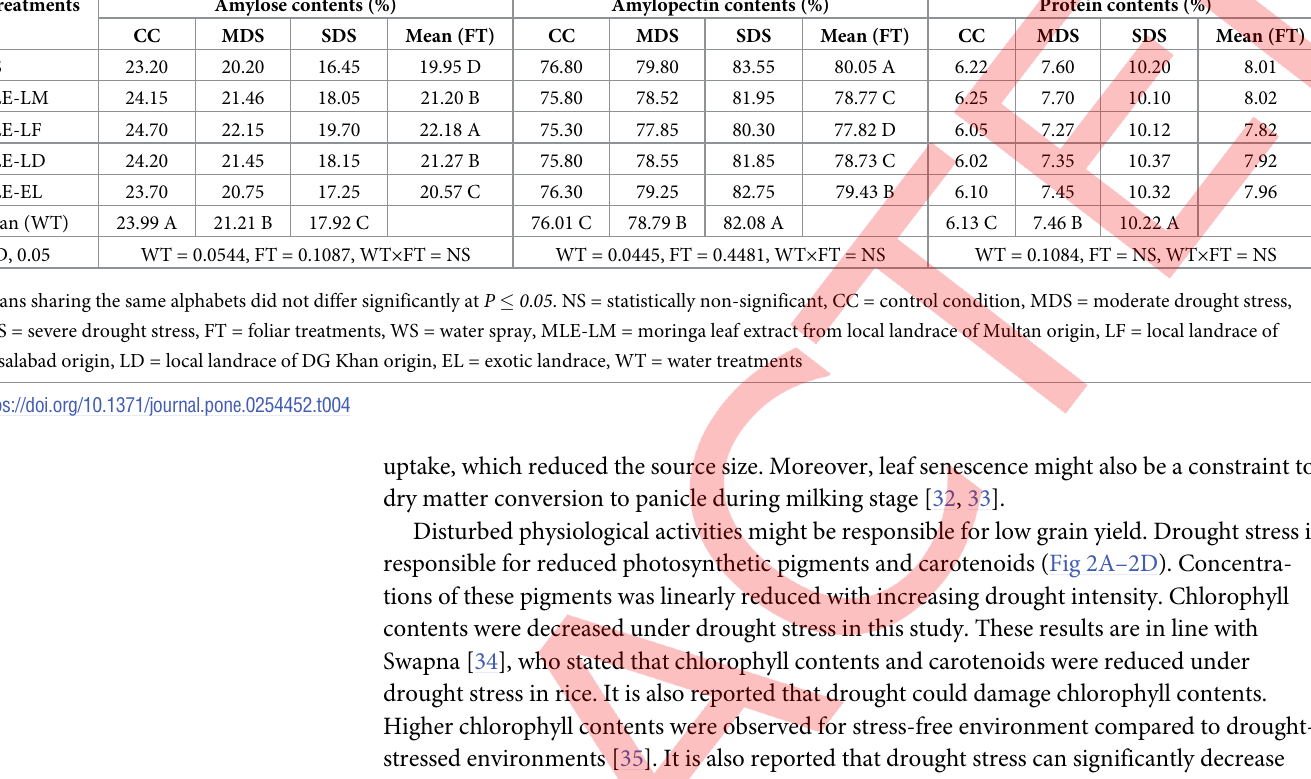
Table 4. Impact of leaf extracts from local and exotic moringa landraces on amylose, amylopectin and protein contents in rice grains cultivated under different lev- els of drought stress (n = 4). Treatments Amylose contents